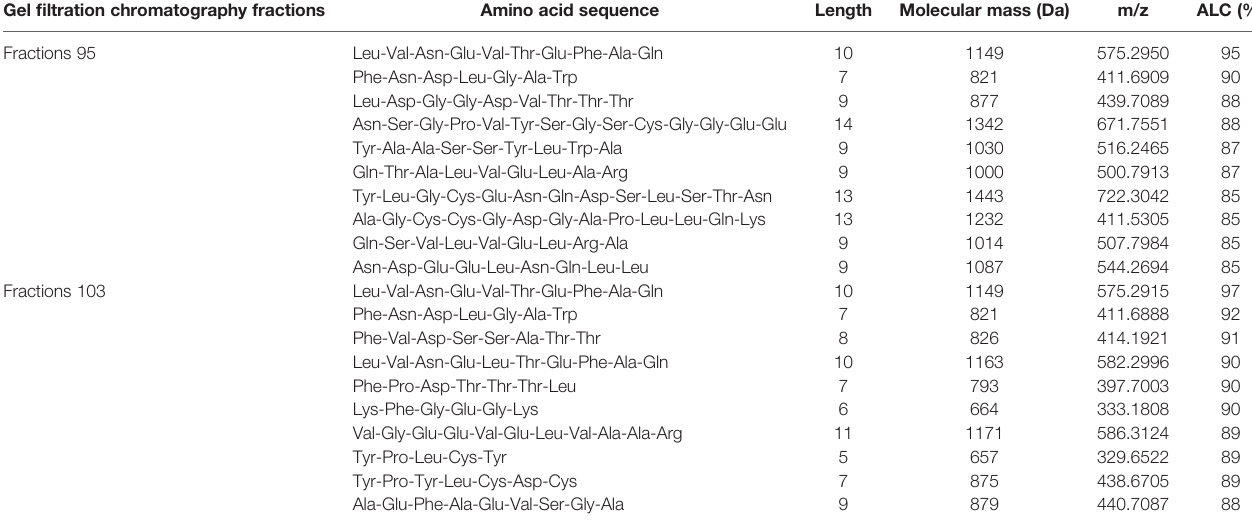
TABLE 8 | Amino acid sequence of peptide in the selected fractions from gel fi ltration chromatography of sea cucumber ( Holothuria scabra ) hydrolysate prepared with papain. Gel fi ltration chromatography fractions Amino acid